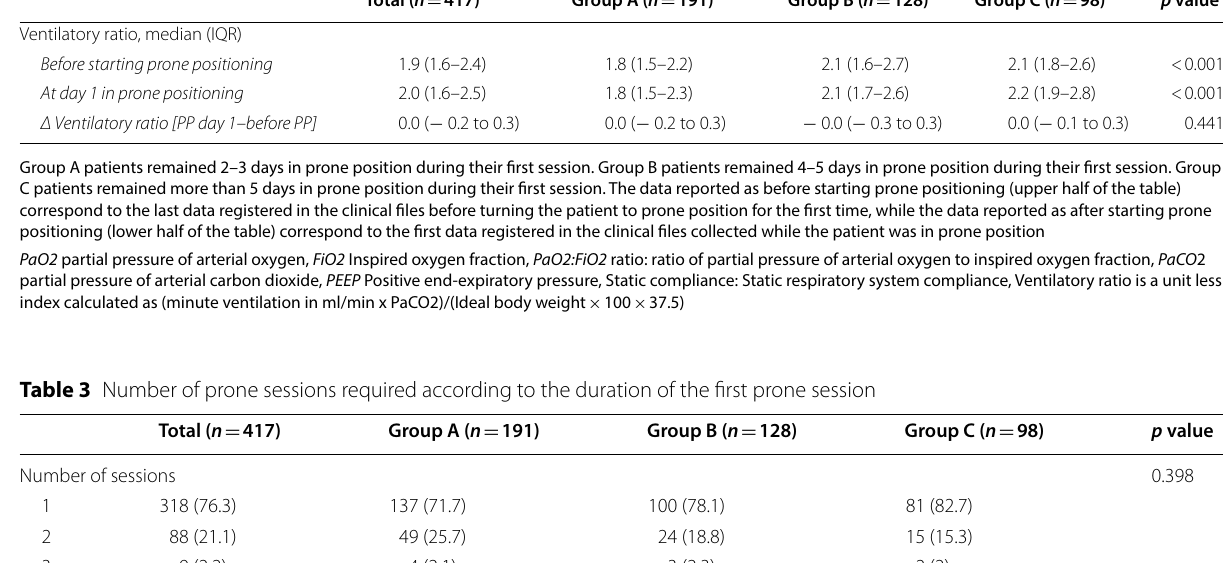
Data are n (%). Group A patients remained 2–3 days in prone position during their first session. Group B patients remained 4–5 days in prone position during their first session. Group C patients remained more than 5 days in prone position during their first session